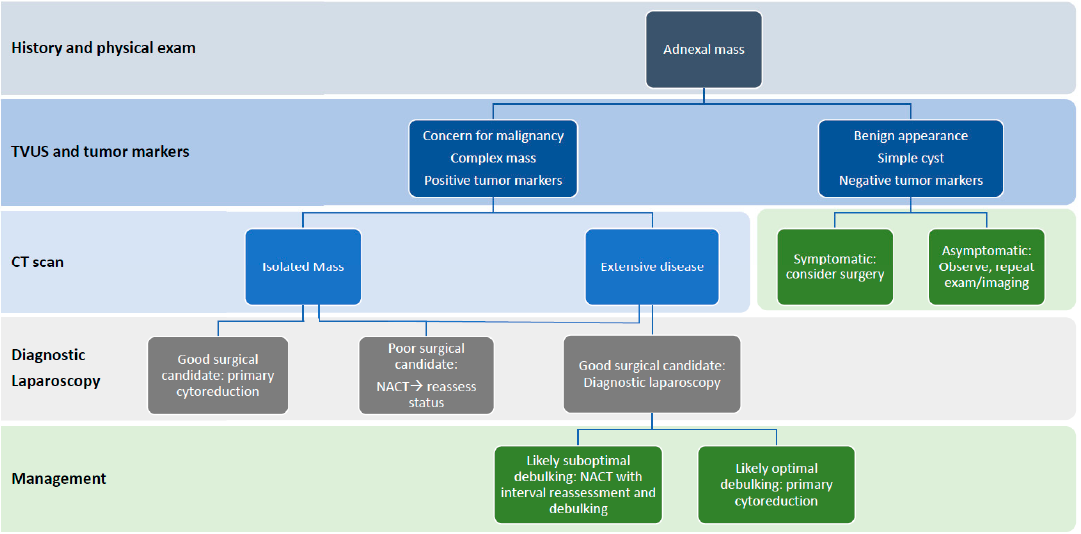
Figure 1. Preoperative assessment and management of an adnexal mass in a nonpregnant patient.